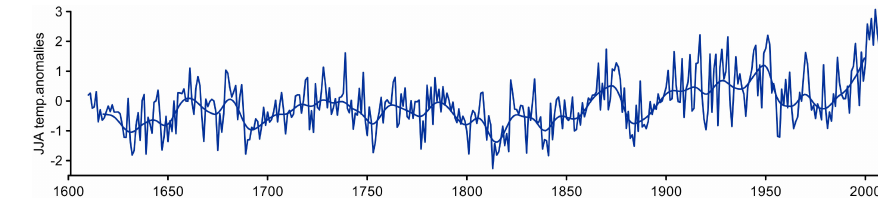
Fig. 6. The unfiltered and smoothed (20-yr low-pass filter) final AdaPres JJA temperature reconstruction.